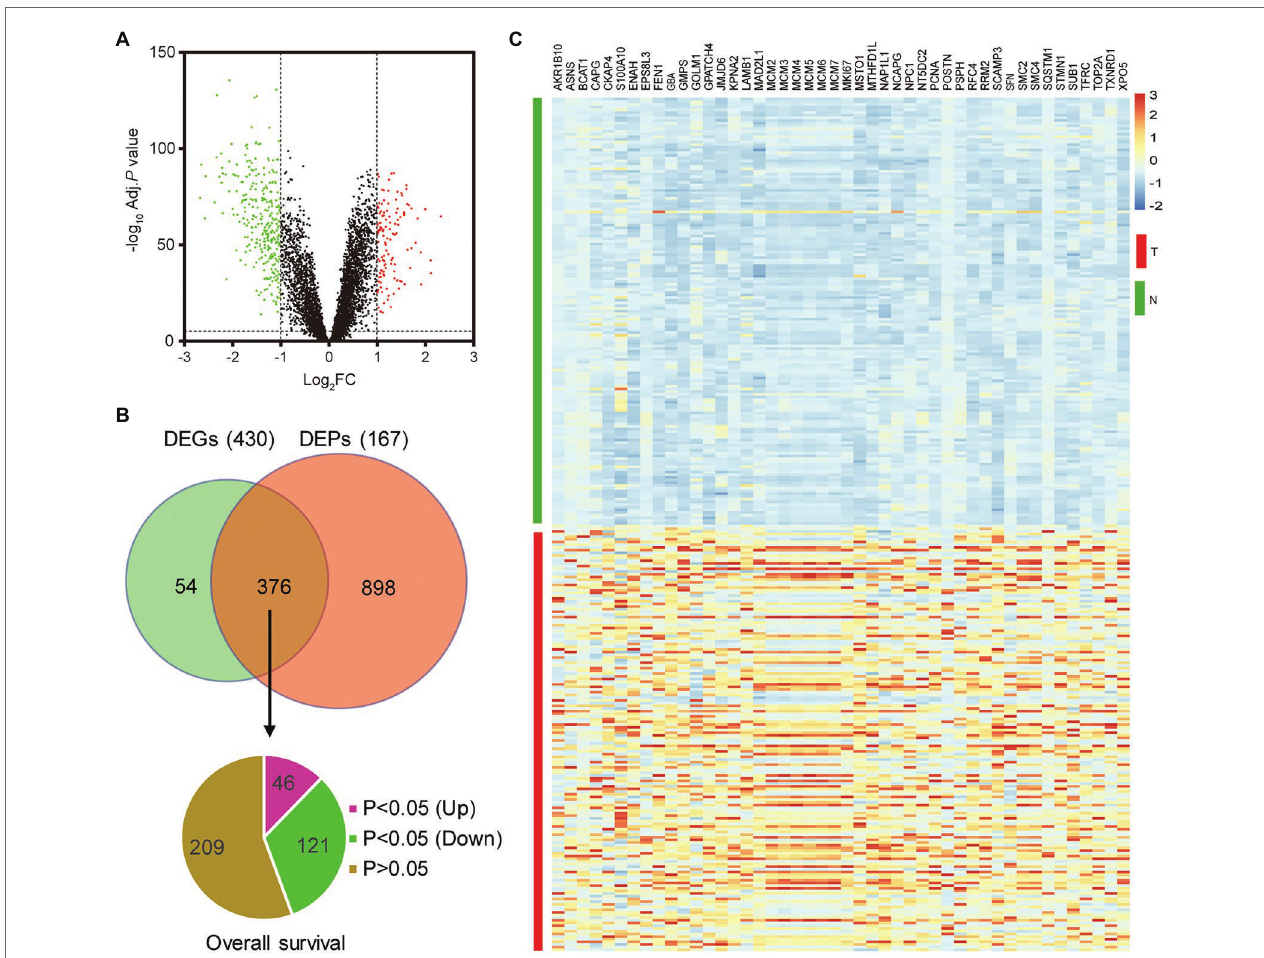
FIGURE 1 | S100 calcium binding protein A10 (S100A10) is identified as a potential oncogene in hepatocellular carcinoma (HCC). (A) Volcano plot of the differentially expressed genes (DEGs). The red dots were increasing genes, and green dots were reducing genes in HCC tumor samples, respectively. (B) Identification of potential oncogene in HCC. Venn diagram of DEGs and differentially expressed proteins (DEPs) with miRNA-protein correlation > 0.45. Pie chart of 376 selected genes, including 167 (46 upregulated and 121 downregulated in HCC) survival-associated genes and 209 non-survival-associated genes. (C) Heat map of the 46 potential